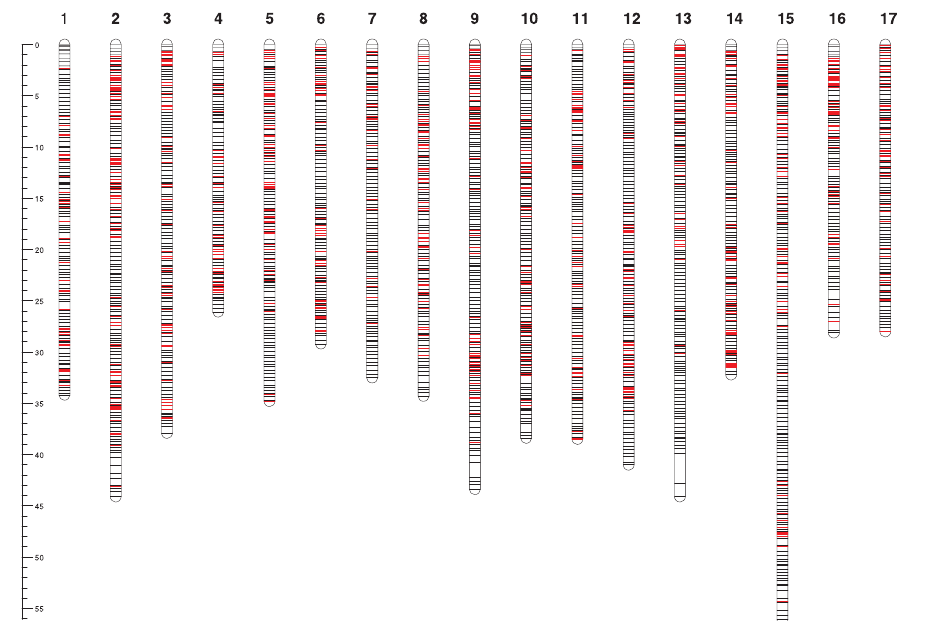
Figure 3. Distribution of focal points (FPs) (black lines) and IRSC SNPs (red lines) in the apple physical map v2. All positions are in Mbps. The average distance between FPs is 311 Kbps. Only two regions longer than 1 Mbps located at the distal end of Chrs 9 and 13 are not covered by FPs and SNPs from the 8 K IRSC SNP array. Scale bars=5 Mbps.